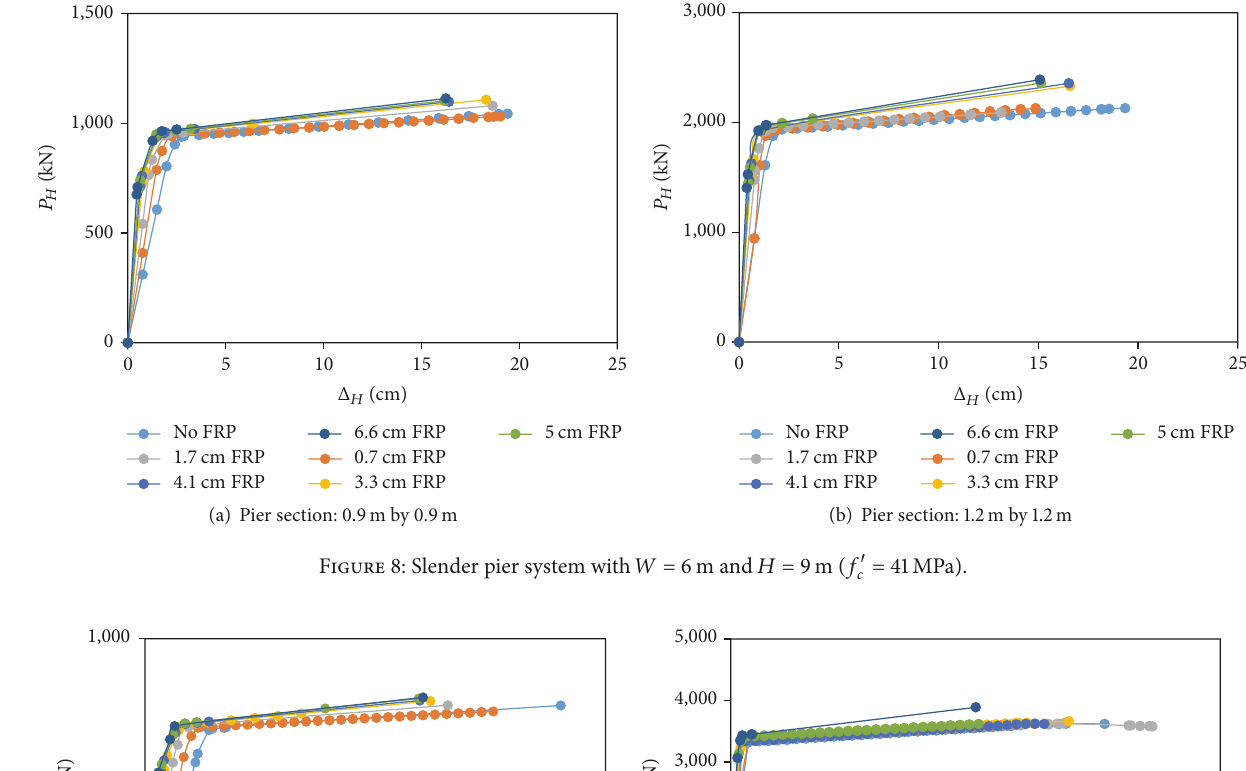
Figure 8: Slender pier system with 𝑊 = 6 m and 𝐻 = 9 m ( 𝑓 󸀠 𝑐 = 41 MPa).